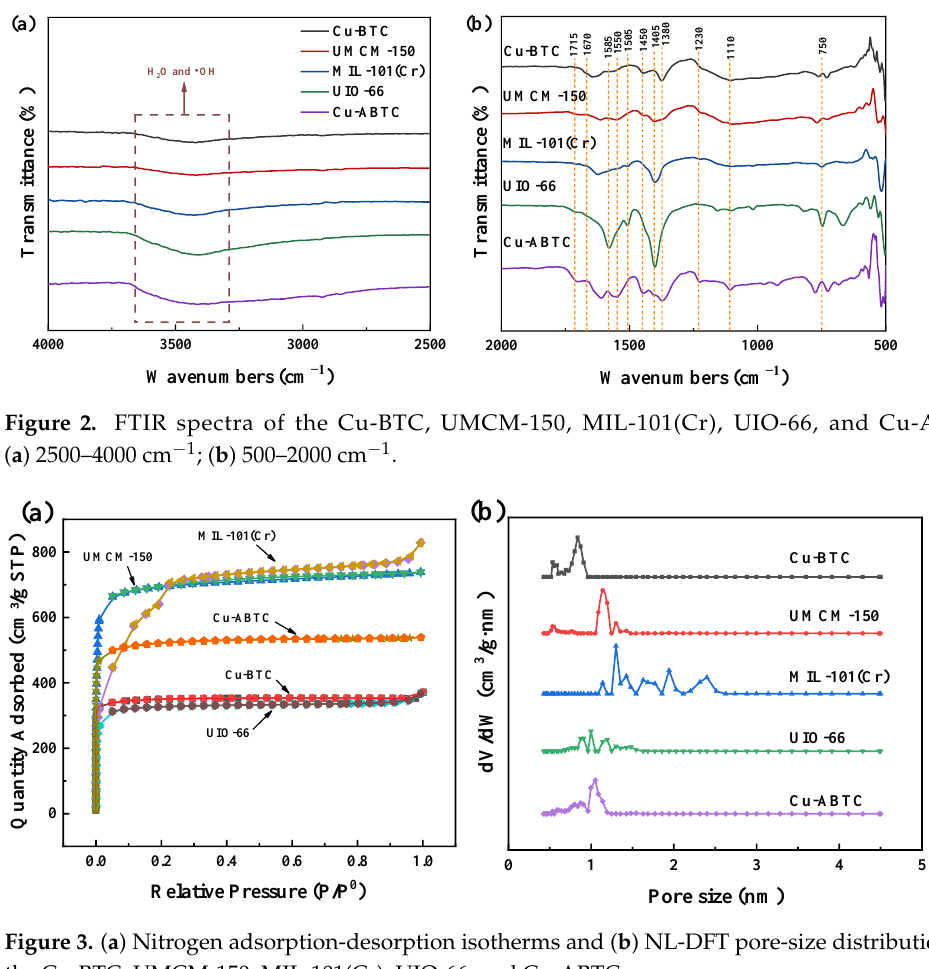
Figure 2. FTIR spectra of the Cu-BTC, UMCM-150, MIL-101(Cr), UIO-66, and Cu-ABTC, ( a ) 2500 – 4000 cm −1 ; ( b ) 500 – 2000 cm −1 .